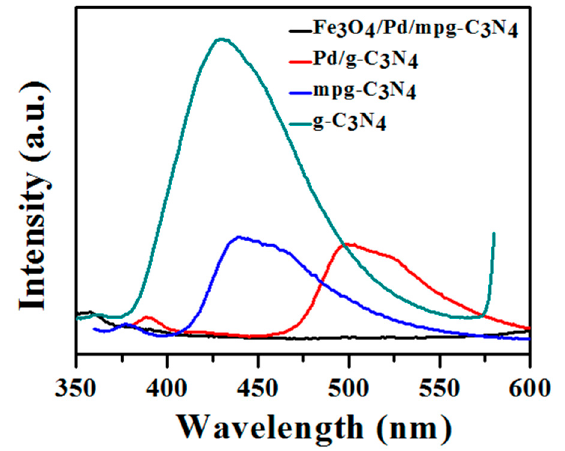
Figure 3. Photoluminescence (PL) spectra of normal g-C 3 N 4 , mpg-C 3 N 4 , Pd / mpg-C 3 N 4 hybrid, and Fe 3 O 4 / Pd / mpg-C 3 N 4 nanocomposite.